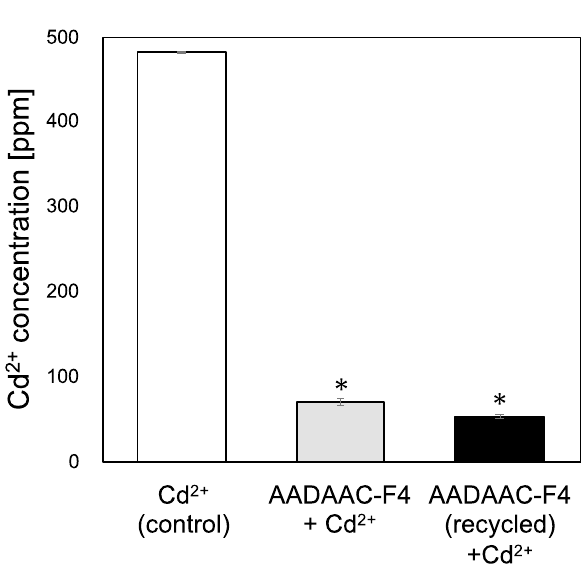
Figure 5. Cd 2+ binding affinity of regenerated AADAAC-F4. Concentration of Cd 2+ in the supernatant of the CdCl 2 solution (4.26 mM) measured after treatment with AADAAC-F4 or recycled AADAAC-F4. * P < 0.05 in a t -test between the concentration after treatment with each peptide compared to that of the control. There was no significant difference in Cd 2+ concentration between AADAAC-F4 + Cd 2+ and AADAAC-F4 (recycled) + Cd 2+ .